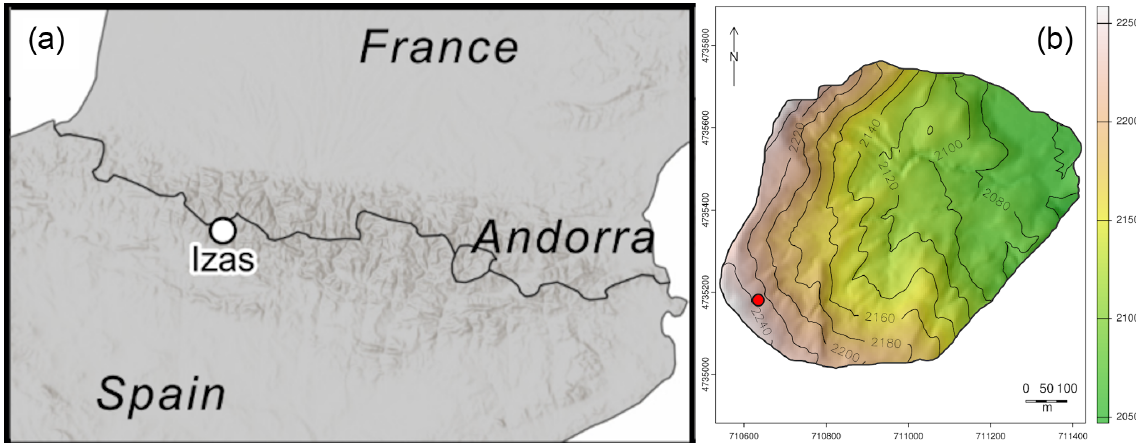
Figure 2. Location of the Izas experimental basin in the Pyrenees (a) and topography (b) . The red circle indicates the location of the cell used for the intercomparison of algorithms described